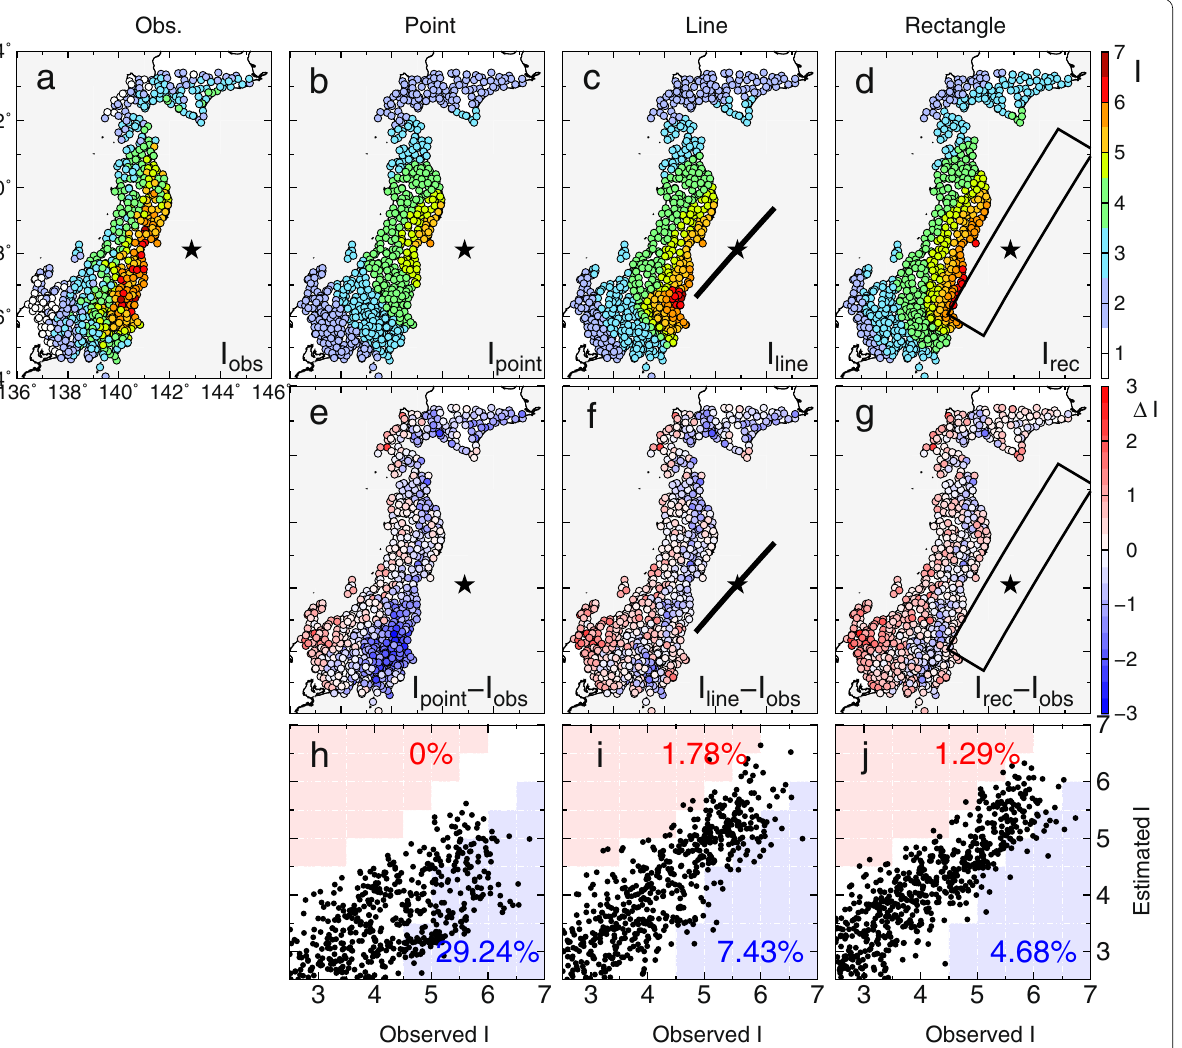
Fig. 6 Distribution of the seismic intensity and its error at 180 s for the 2011 Tohoku earthquake. The observation and the estimations of the PS, LS, and RS models are shown from the left. Black stars and thick lines show the epicenters and the source models, respectively. a Observed intensity. b – d Estimated intensity for the 3 source models. e – g Difference between the estimated and observed intensities for the 3 source models. h – j Scatter plot of the observed and estimated intensities for the 3 source models. The red color indicates over-predicted, and the blue color shows under-predicted. The percentage of the stations with an error > 1 is written in the